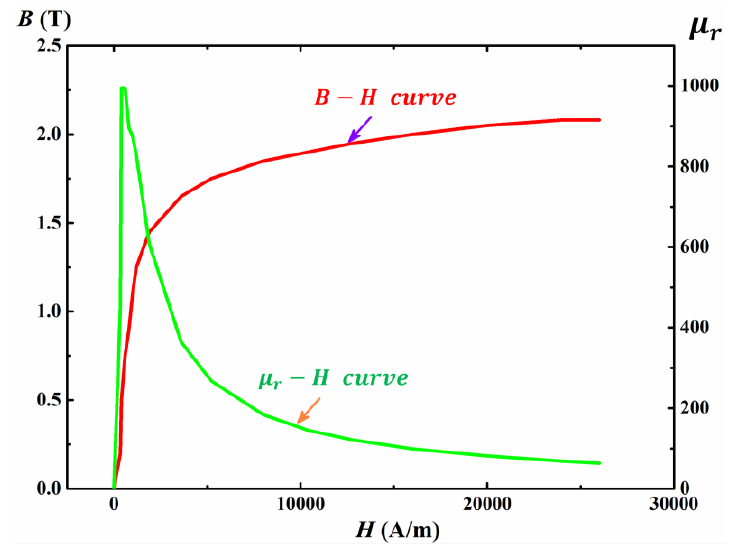
Figure 2. Magnetic characteristic of 20# steel.